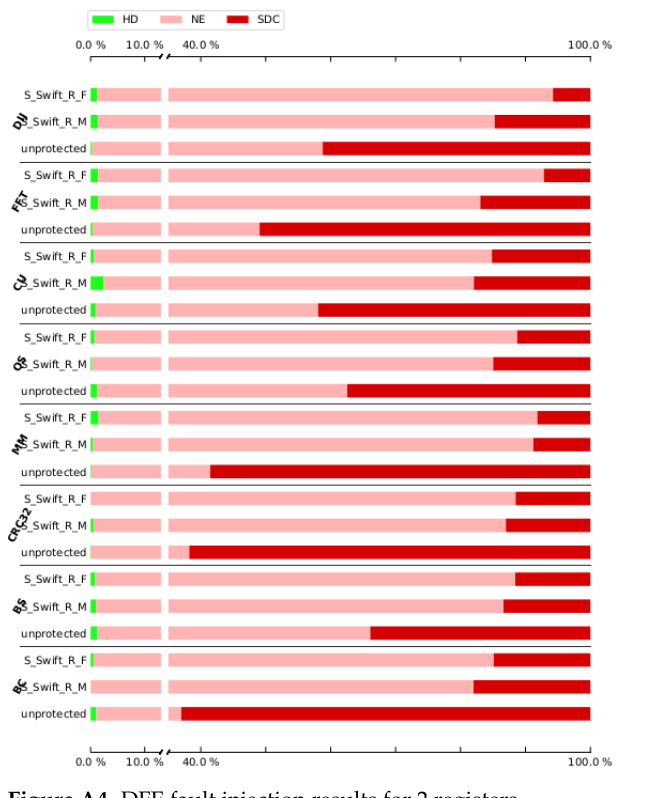
Figure A4. DFE fault injection results for 2 registers.